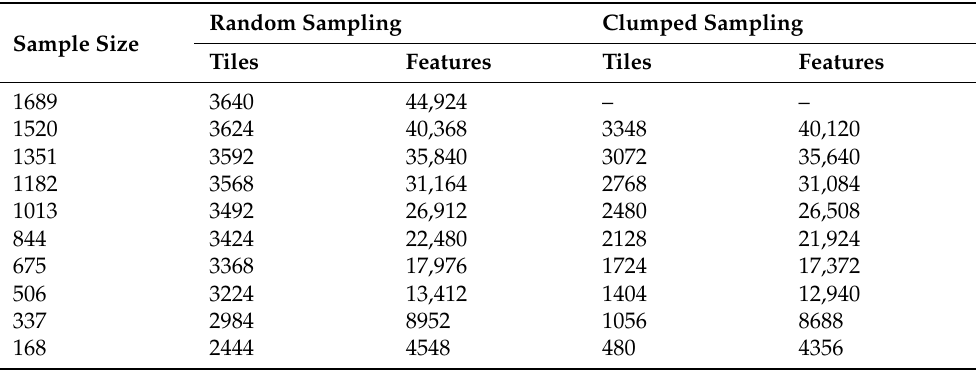
Table 1. The number of image tiles and features on each training dataset.